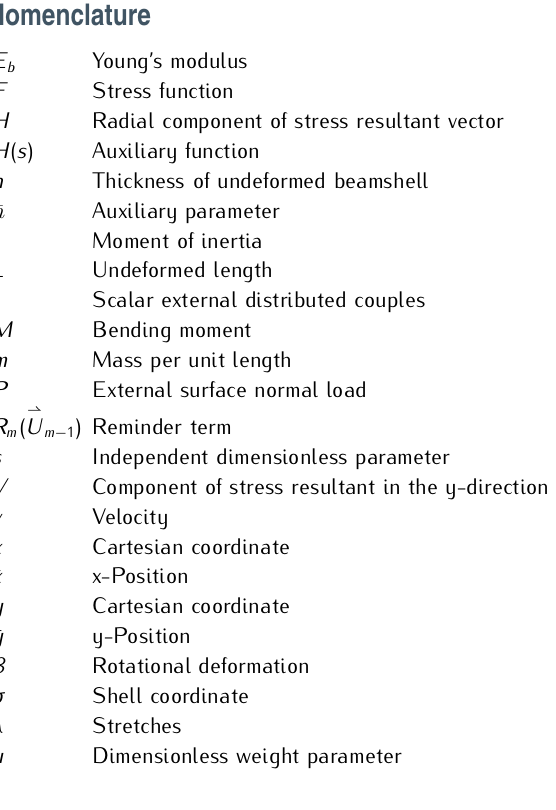
that the presented method is a suitable and efficient tech- nique for the analysis of nonlinear and large deflection beamshell problems, and that it can be used for wide range of loads and lengths for beamshells with variable proper-